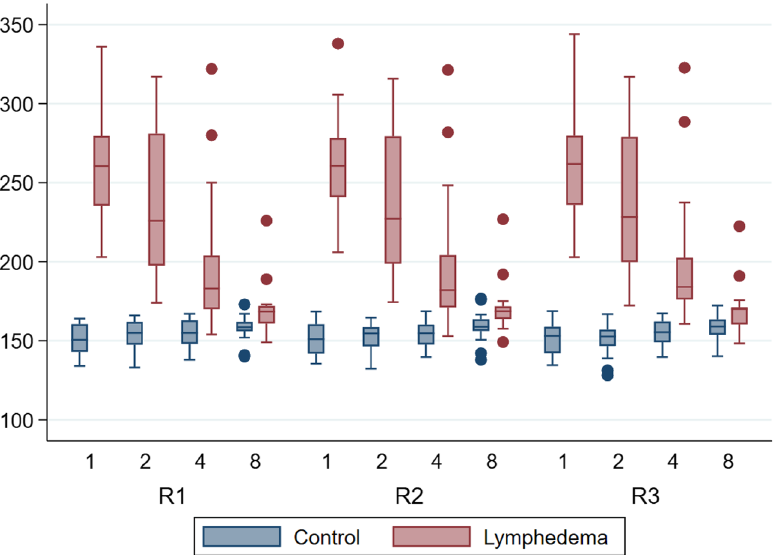
Figure 1. Descriptive boxplot showing the µCT-scans by rater, week and group. The y-axis is in cubic millimeters [mm 3 ]. The x-axis is weeks. CT computed tomography, μ micro, R1 rater 1, R2 rater 2, R3 rater